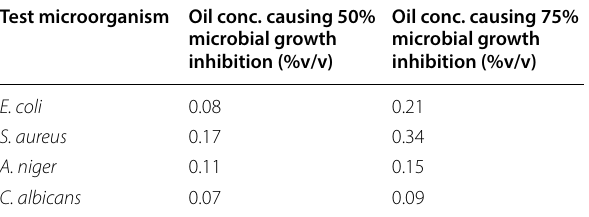
Concentrations are calculated from dose–response curve (Fig. 1)